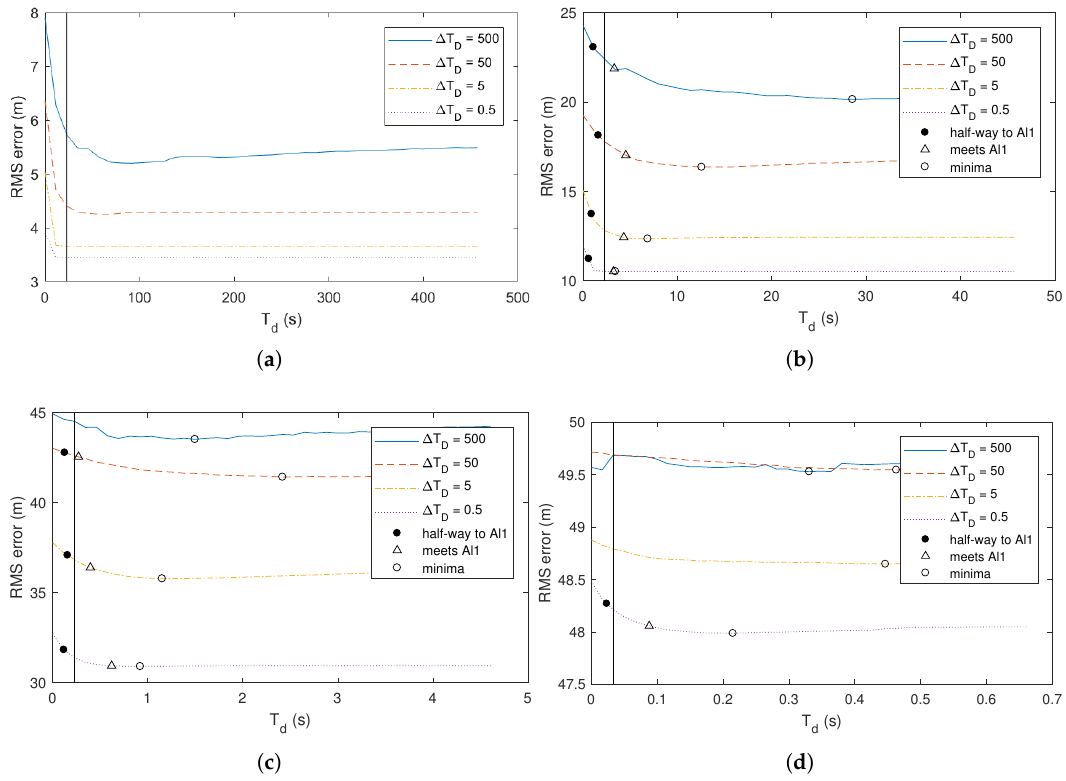
Figure 6. Performance of selective out-of-sequence filters as a function of the cut-off time T stale for a wide range of ∆ T D viewing a narrow time-scale. The vertical line represents the theoretical cut-off T d computed using (8) with a k min / k value of 0.6. ( a ) σ Q = 0.5, σ R = 50; ( b ) σ Q = 5, σ R =